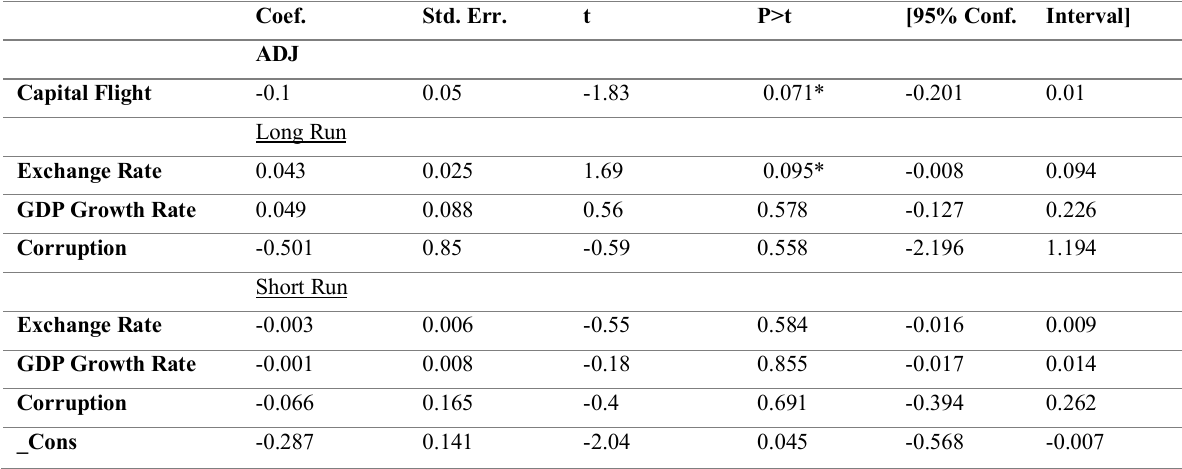
Table 7: ARDL model with long run and short run models